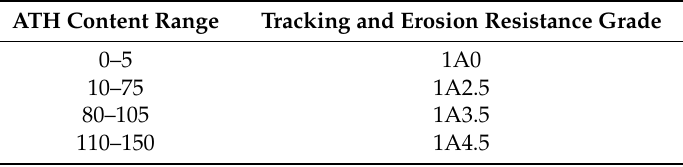
Table 5. Summary of the tracking and erosion resistance classification for all samples and the corresponding test condition. ATH Content Range